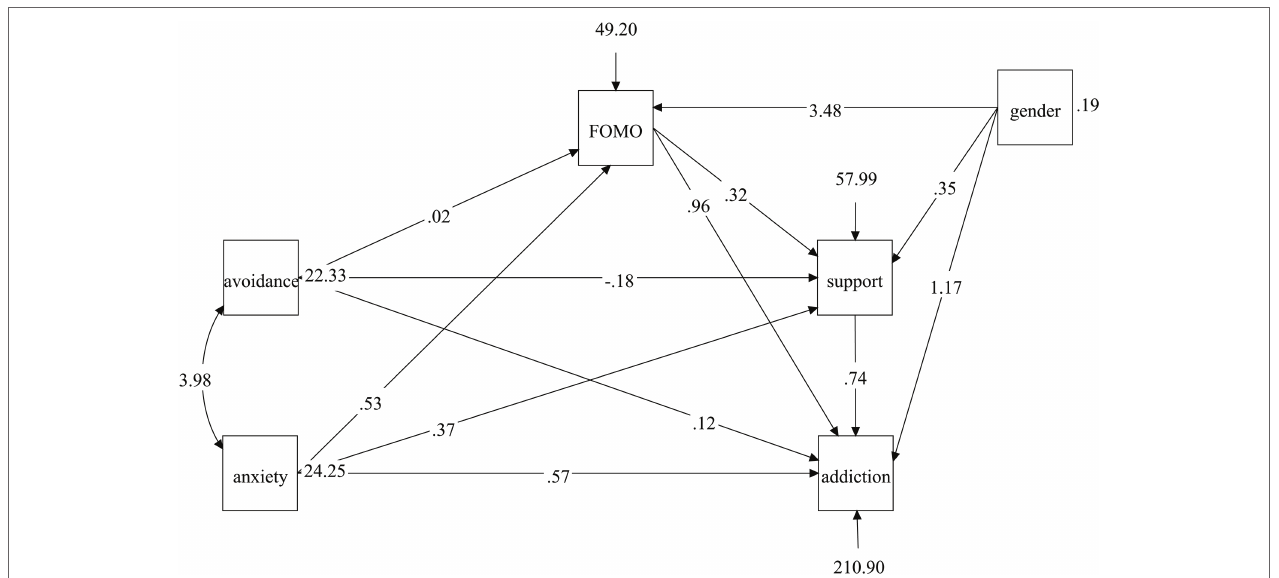
FIGURE 2 | The unstandardized coefficients of the model. All the paths were significant, except the path from avoidant attachment to FOMO and SNS addiction. Gender was added as a control